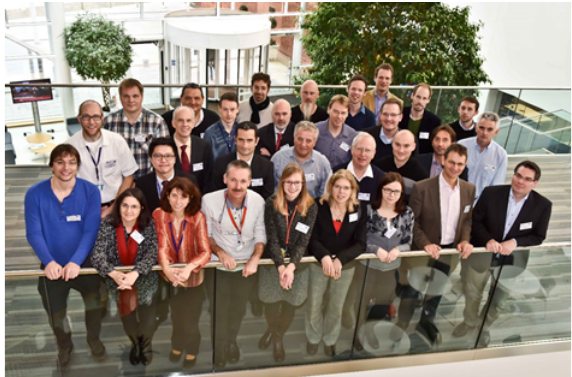
Figure 2. Eurosdr/ISPRS workshop ‘Efficient capturing of 3D objects at a national level: with a focus on buildings and infrastructure', 27 - 28 november 2014 (Ordnance Survey, Southampton,